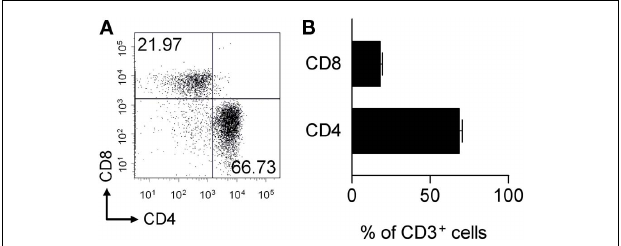
restimulation of CD4-depleted LN cells with pMOG. After five rounds of stimulation, (C) T cells were tested for recall responses to pMOG or (D) to the indicated peptides. (E) A MOG − / − CD8 + T cell line was cultured with dose ranges of the indicated peptides. Each experiment shown is one of two/three experiments giving consistent